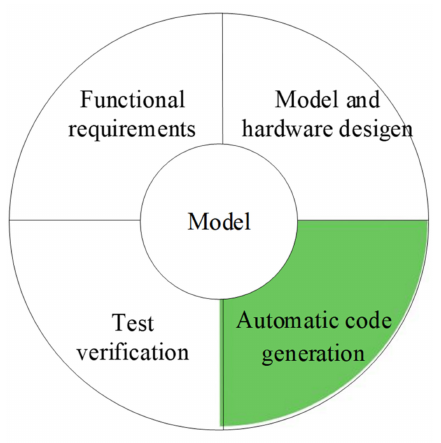
Figure 2. The model-based